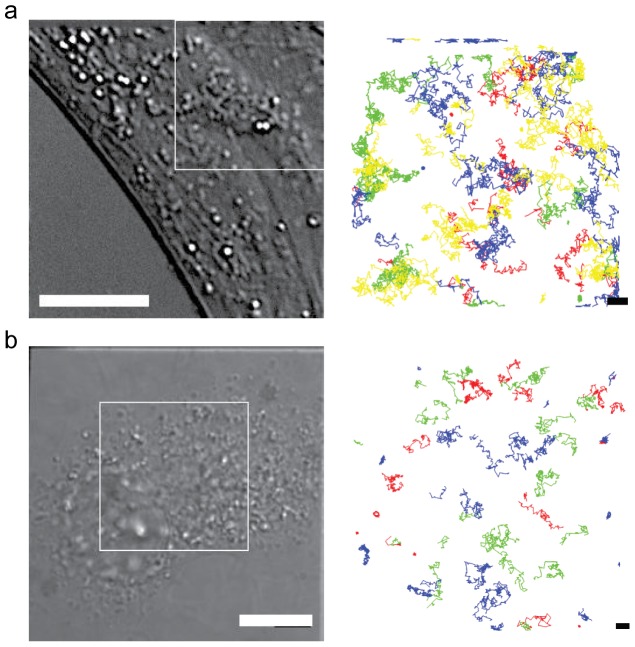
Multi-color QD single molecule imaging in live MEFs.Differential interference contrast images (left column, scale bar = 10 µm) and superimposed trajectories from SPT analysis (right column, scale bar = 1 µm) in selected regions-of-interests (ROIs). (a) Four color single QD time-lapse imaging of an artificial lipid, biotin-cap-DPPE, labeled by a four color combination of sAv-QD705 (red), sAv-QD655 (green), sAv-QD605 (blue), and sAv-QD565 (yellow). (b) Three color single orthogonal QD imaging of the sphingolipid, GM1, with ChToxB-QD705 conjugates (red), ACP-CD59with CoA-QD655 conjugates (green), and BLAP-EGFR with sAv-QD605 conjugates (blue).